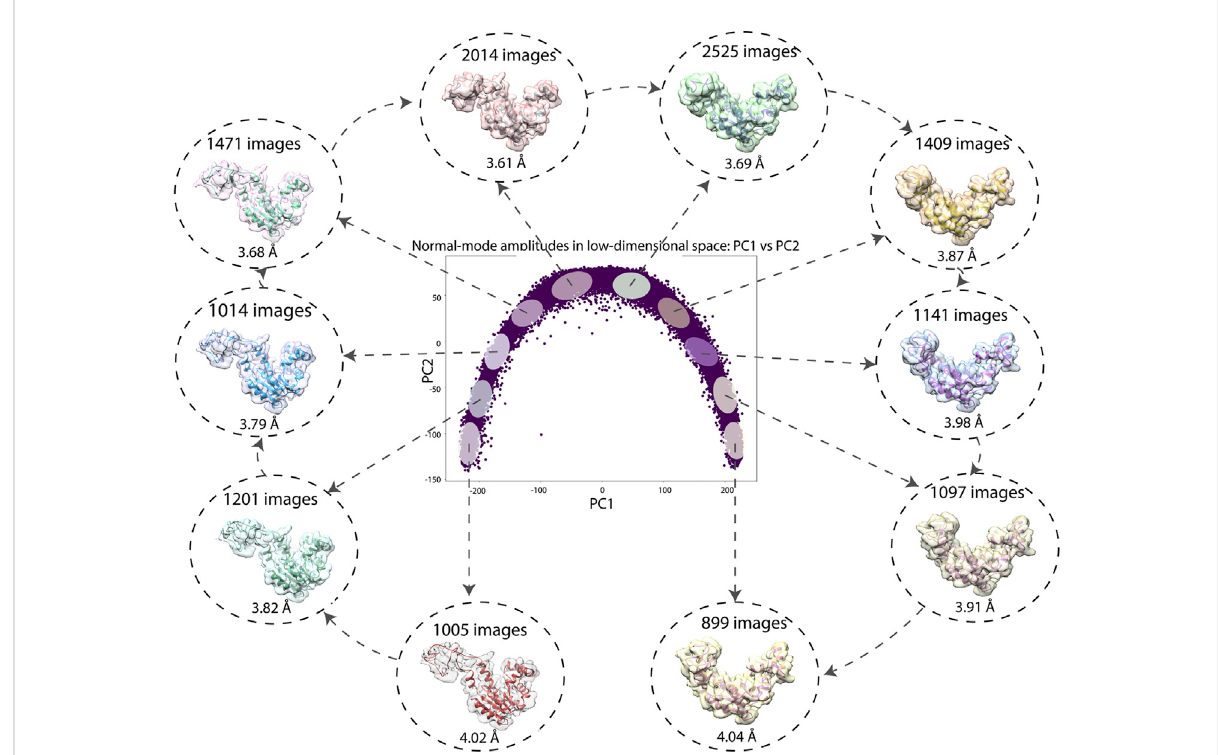
FIGURE 7 Low-dimensional (here, 2D) conformational space obtained by principal component analysis of the inferred conformational parameters (normal-mode amplitudes) for a large test set of 50,000 synthetic images, together with ten 3D reconstructions from ten different dense regions of this space supperposed with the corresponding atomic models (centroids of the regions). The network training and inference of normal-mode amplitudes, angles, shifts were done using images of size 128 × 128 pixels (for the inferrence accuracy, see Tables 3, 4) andthereconstructionswereobtainedfrom imagesof size256×256pixels. Thenumber of imagesusedfor eachreconstructionandthe0.5- FSC resolution of the reconstructed map are also shown (the FSC curves are provided in Supplementary Material SF). Each point in the conformational space corresponds to an image and a molecular conformation inside it. Close points correspond to similar conformations and vice